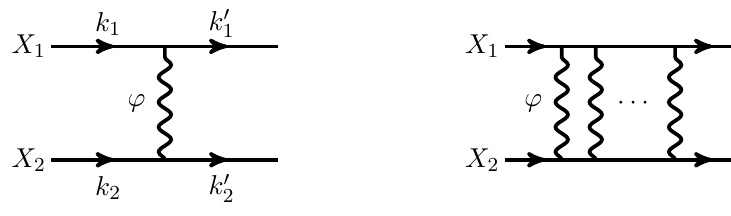
Figure 1a . Left: in the weak-coupling regime, the one-boson (either scalar or vector) exchange is the dominant contribution to the non-relativistic X 1 (cid:0) X 2 potential. Right: the ladder diagrams | arising from the in(cid:12)nite repetition of the one-boson-exchange diagrams | give rise to non- perturbative e(cid:11)ects: the Sommerfeld e(cid:11)ect and the existence of bound states.